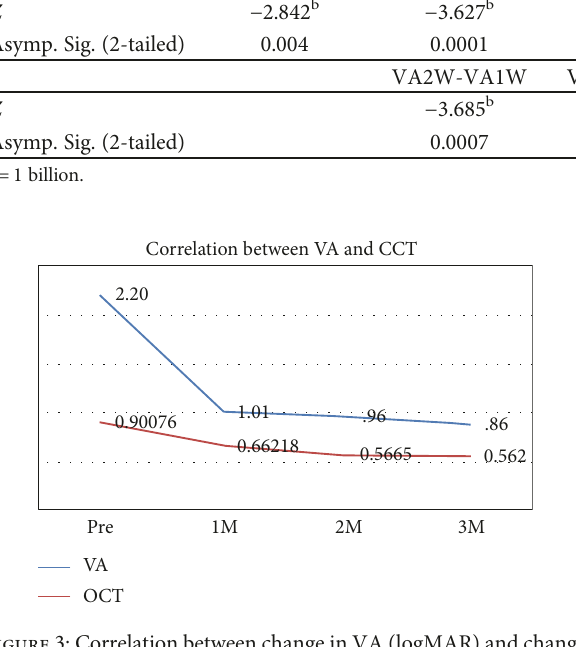
Figure 3: Correlation between change in VA (logMAR) and change in CCT after 1 month, 2 months, and 3 months after